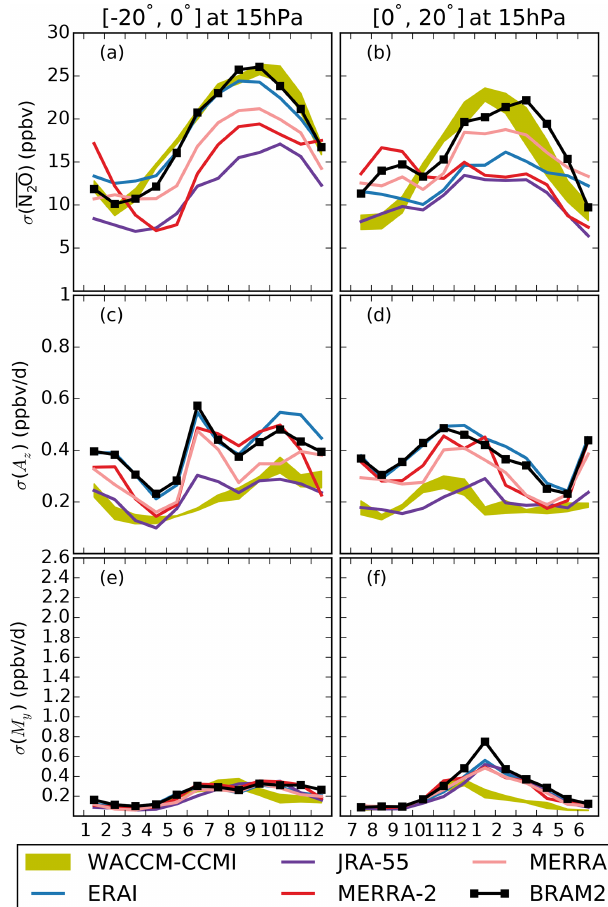
Figure 12. As for Fig. 10 but for the tropics: (a, c, e) southern trop- ics (0–20 ◦ S); (b, d, f) northern tropics (0–20 ◦